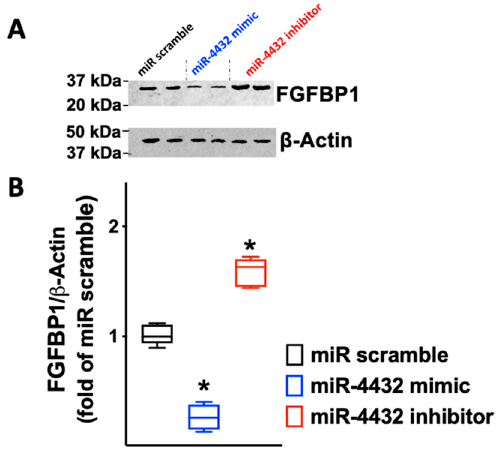
Figure 6. The observations detected by RT-qPCR in terms of mRNA were upheld by Western blots, as shown in the representative blots, showing two biological replicates per condition ( A ) and their quantification ( B ). All assays were carried out at least in triplicate; the graph represents the medians and the 5th to 95th percentiles; *: p < 0.01 vs. miR-scramble.